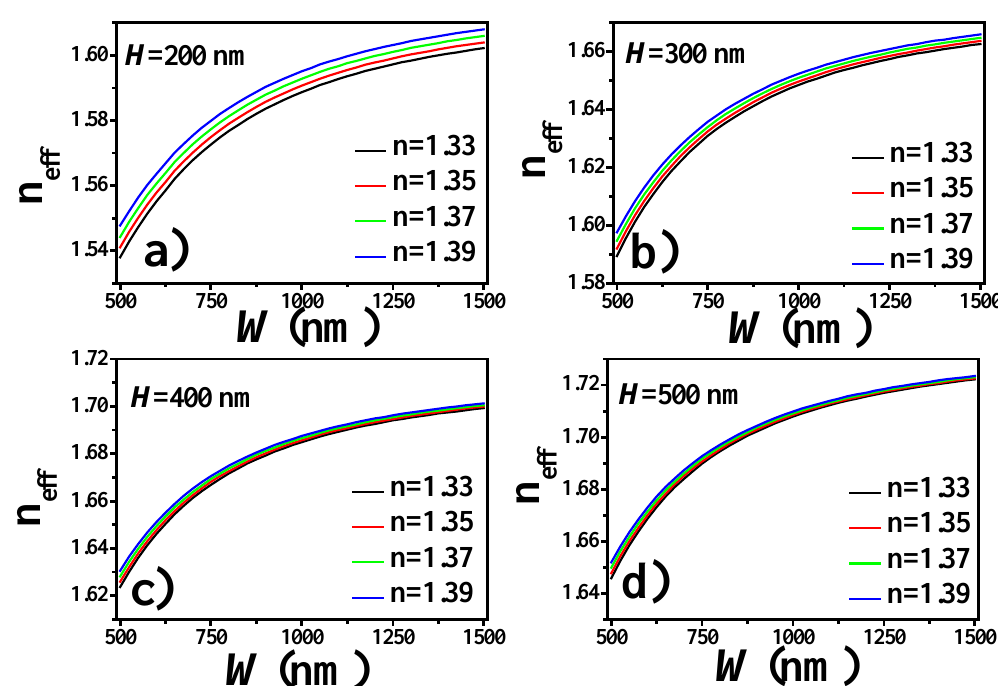
Figure 7. Re( n eff ) versus W for the H of ( a ) 200 nm, ( b ) 300 nm, ( c ) 400 nm and ( d ) 500 nm. Please note that only the TE-fundamental mode was considered.